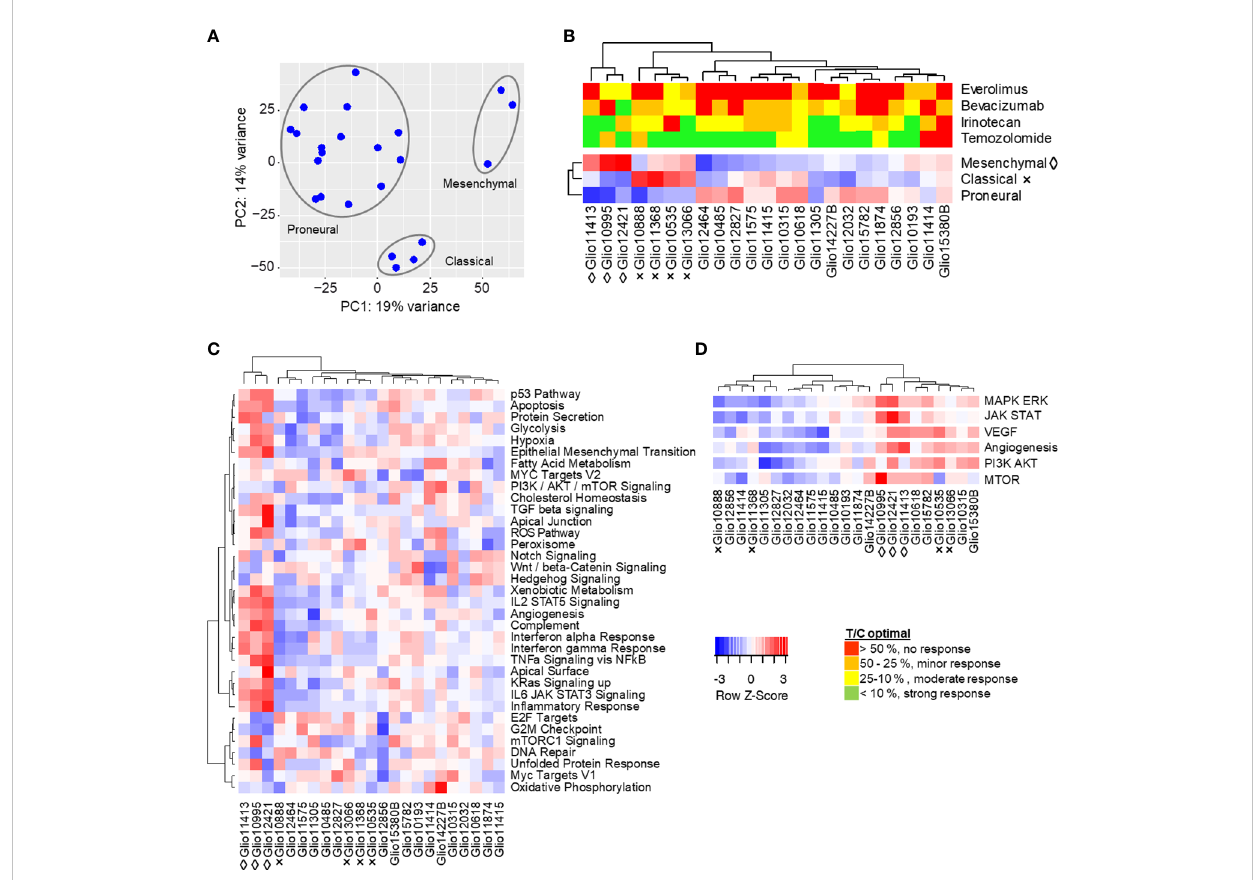
FIGURE 4 Molecular characteristics of s.c. glioma PDX models. (A) Global gene expression of 23 glioma PDX models by principal component analysis. Similarity of transcriptomes is represented by their spacial distribution in the plot, with three custers visible. (B) The observed clustering into three groups could be replicated in subsequent analyses of expressions of gene sets characteristic for proposed molecular subtypes mesenchymal ( ◊ ), classical ( × ) and proneural (no indication). (C) Single sample gene set enrichment analysis of glioma PDX models regarding 34 selected hallmarks and clustering of models resembling the mesenchymal subtype. (D) Combined enrichment scores of gene sets related to MAPK/Erk, JAK/STAT, VEGF, PI3K/Akt and mTOR signaling, as well as angiogenesis. Gene sets analyzed individually in Figure S3. Red (positive Z-score): higher expression of gene set than in the average of all models. Blue (negative Z-score): lower